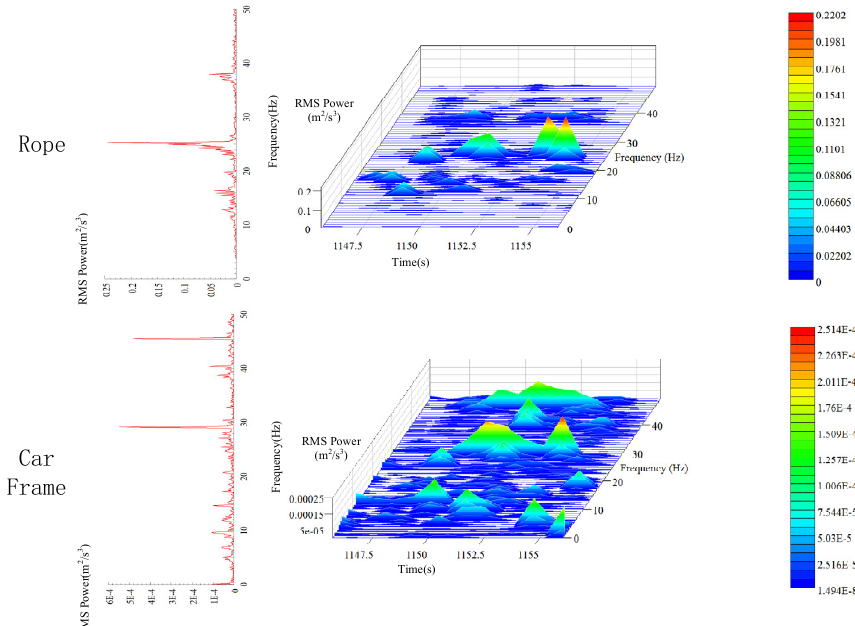
Figure 12. Time-frequency characteristics of transverse vibration of the hoist rope and car frame.